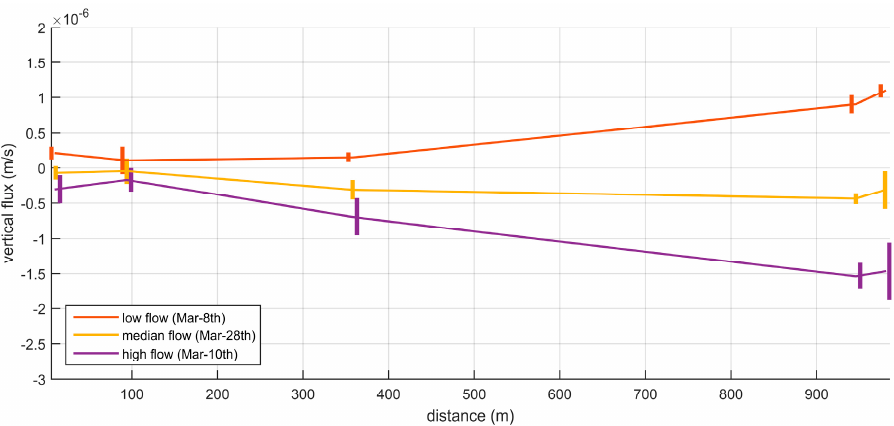
Figure 12. Estimated vertical fluxes at the five iButton locations under three representative flow conditions.